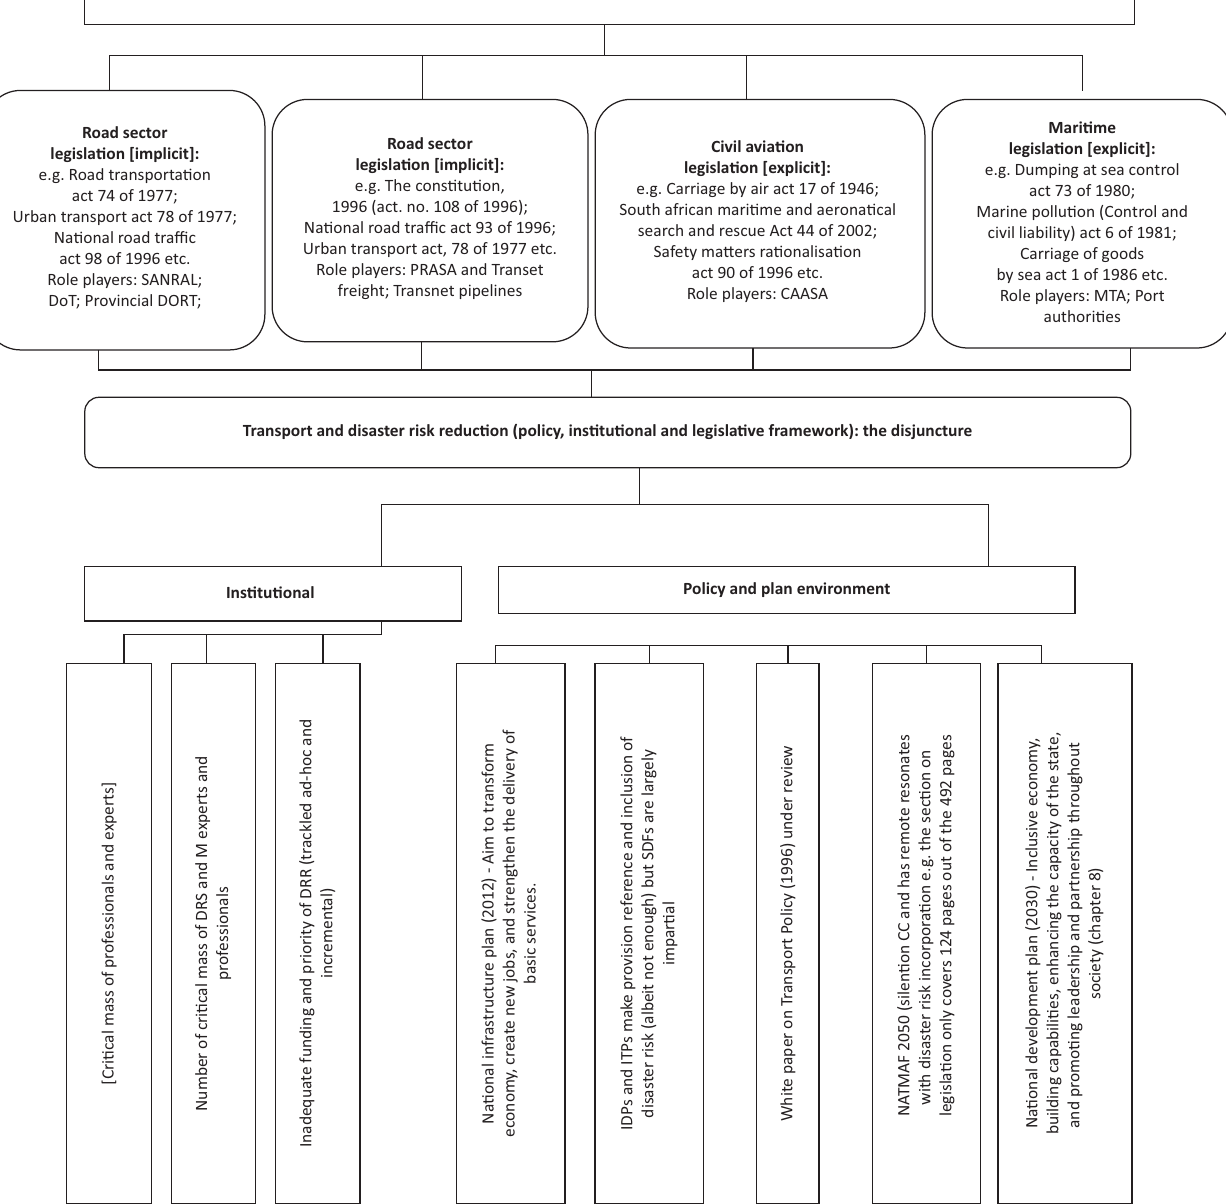
FIG URE 2: Transportation sector policy, legal and institutional frameworks for disaster risk reduction in South